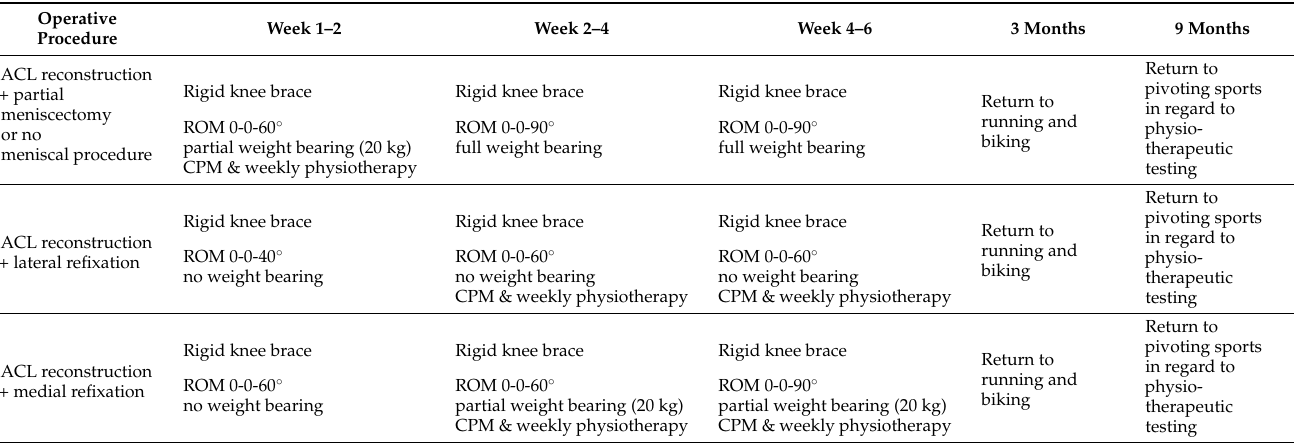
Table 1. Postoperative care and remobilization.